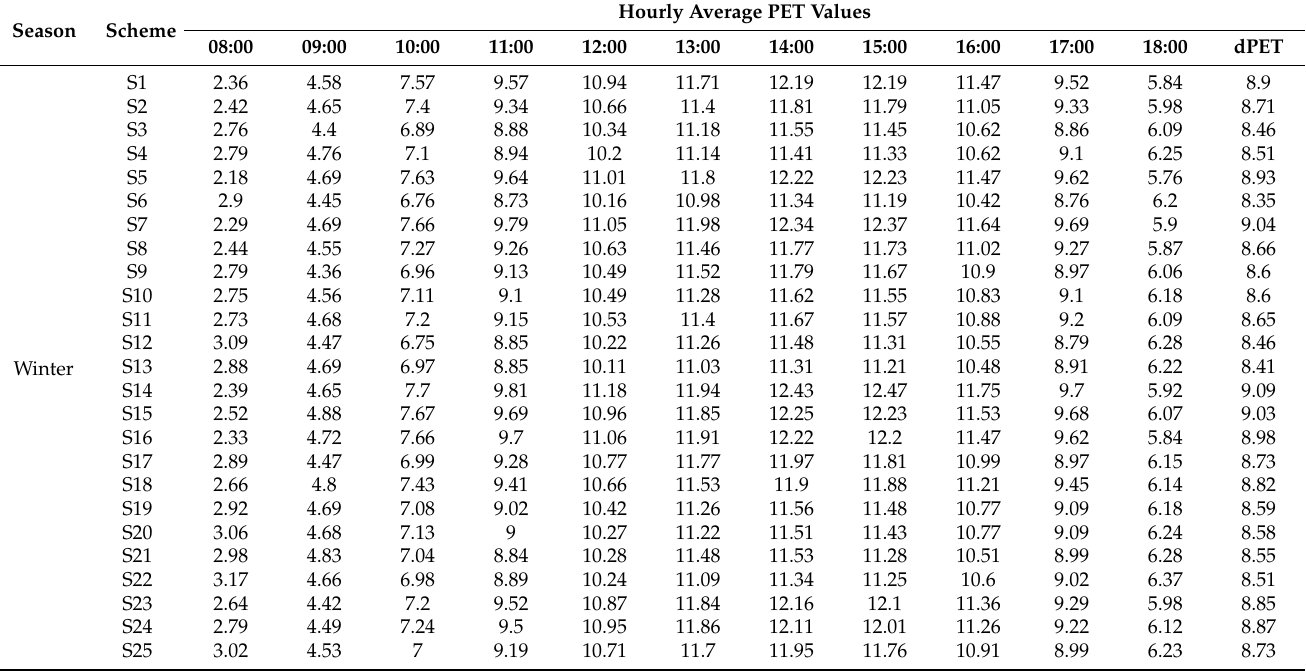
Table A1. Hourly average PET-value changes of each scheme in winter and